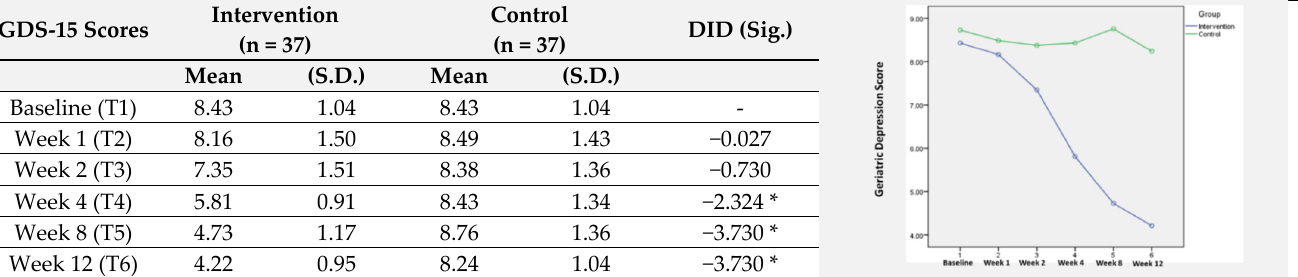
Table 2. Comparison of mean GDS-15 scores between groups over time.